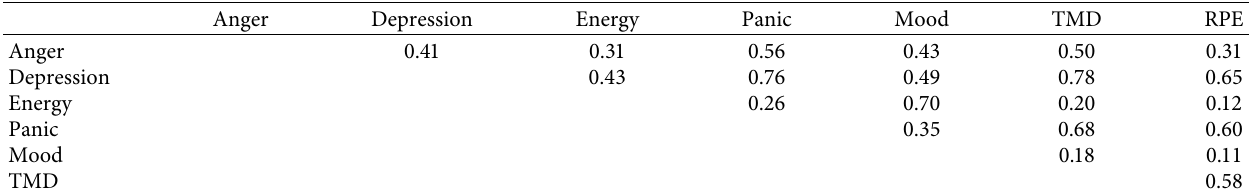
Table 3: Statistical table of correlation between RPE and POMS subscales (Pearson’s coefficient r ).